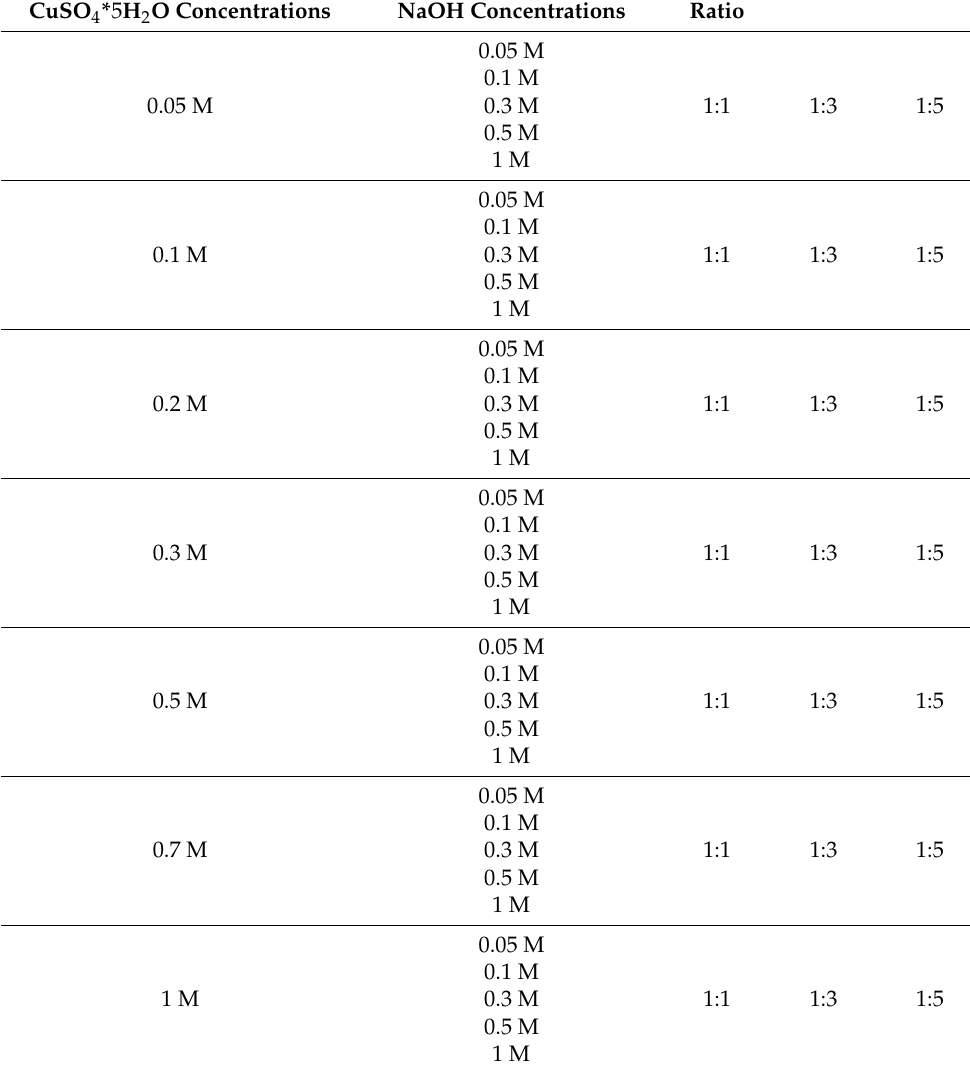
Table 1. Concentrations and ratios of CuSO 4 *5H 2 O and NaOH for electrode modification. CuSO 4 * 5 H 2 O